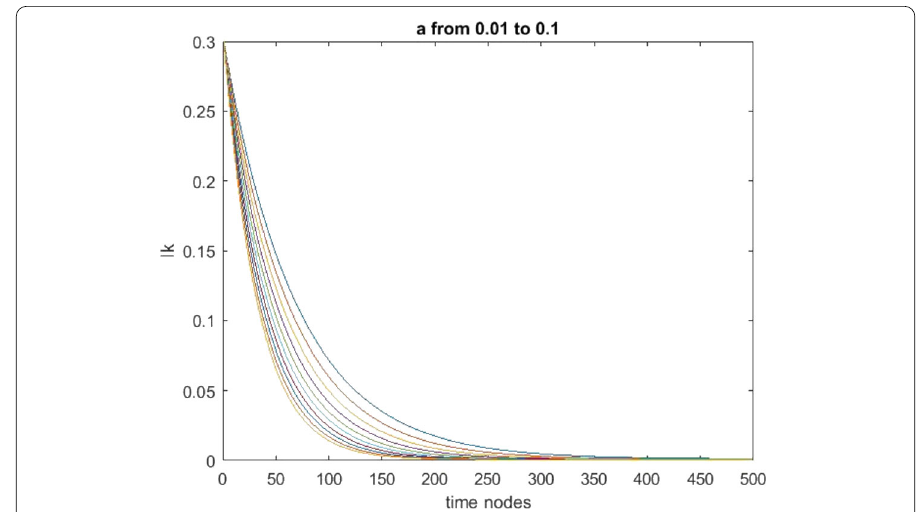
Figure 3 The influence of parameter a on the decay rate when k = 20